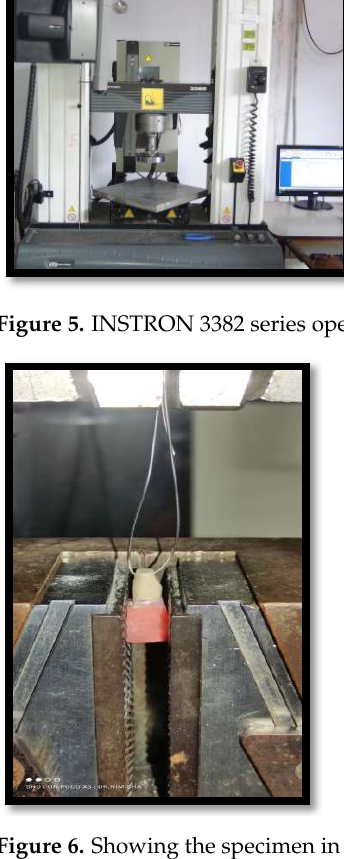
Figure 6. Showing the specimen in Universal Testing Machine.